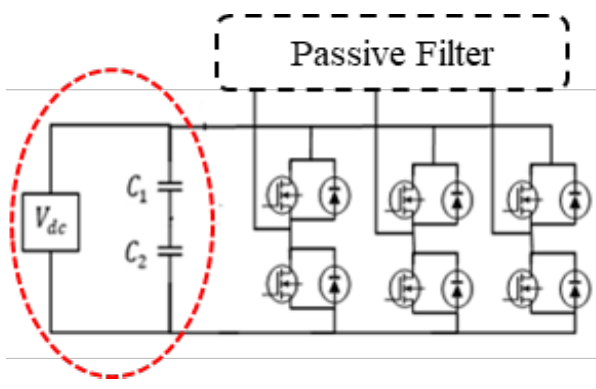
Figure 5. DC-link capacitors for